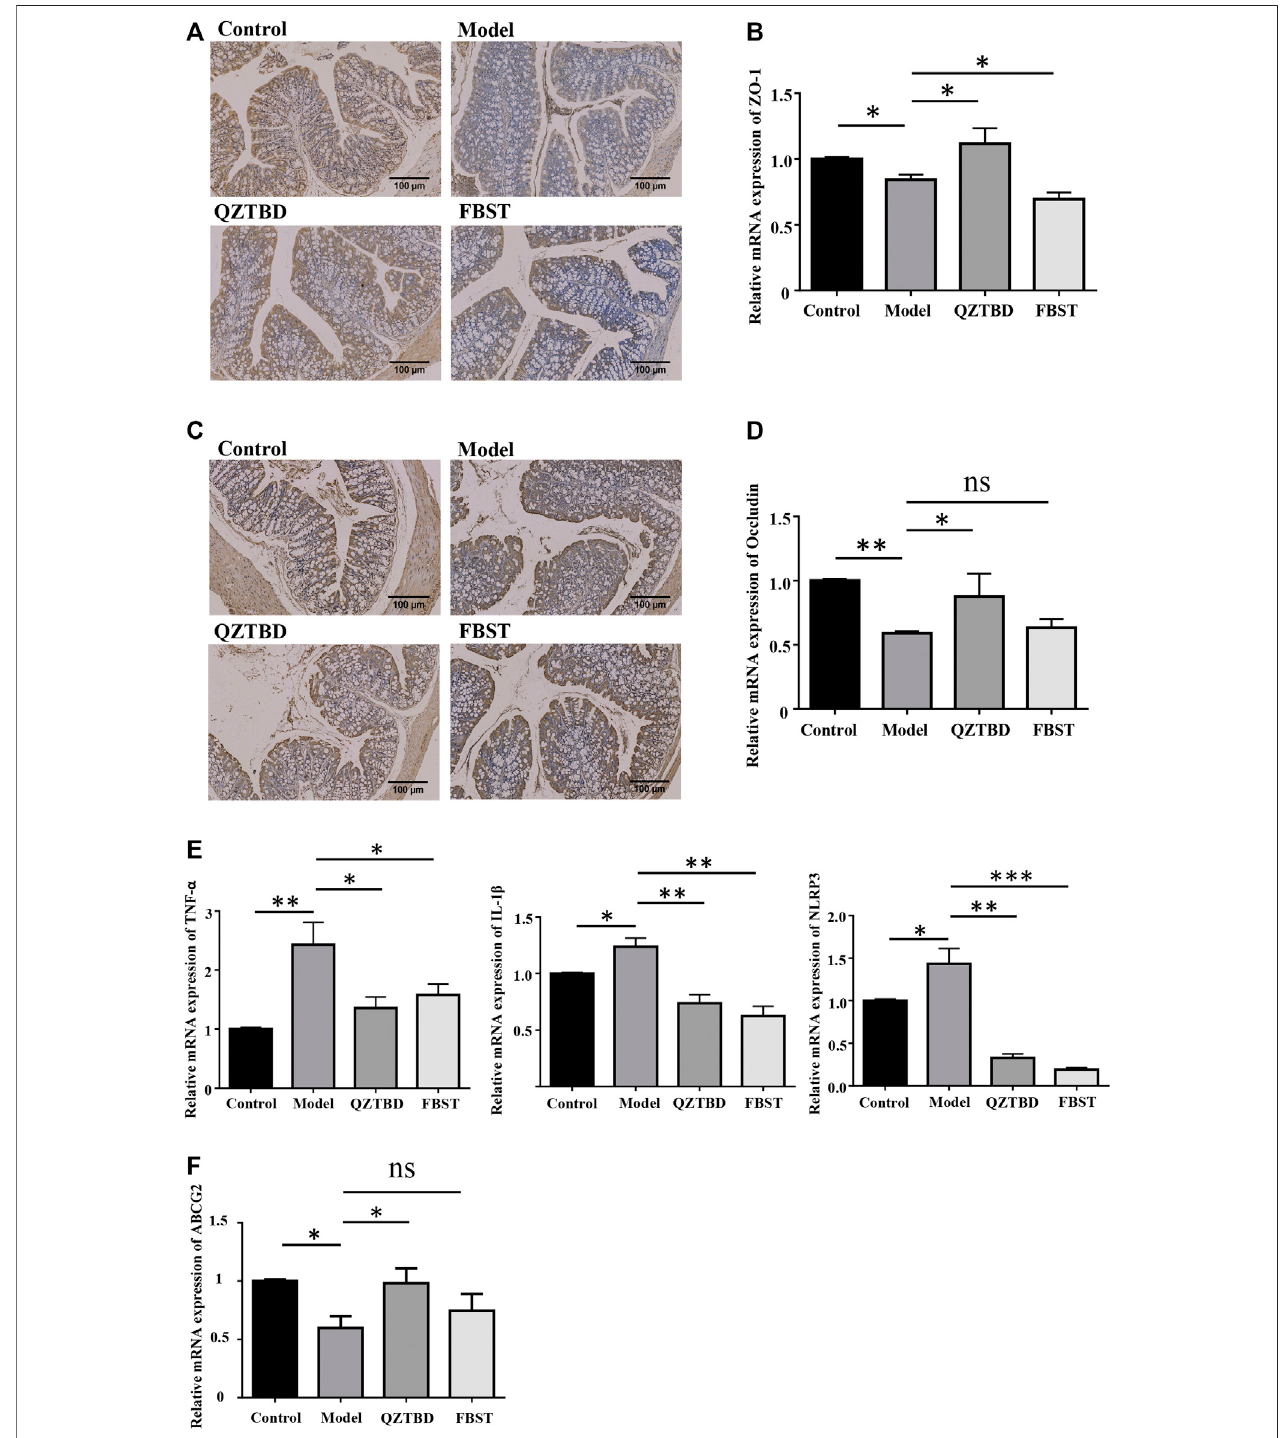
FIGURE 6 | QZTBD improved intestinal mucosal barrier. Expression of ZO-1 in the colon was measured by immunohistochemistry (A) and q RT-PCR (B) ; Expression of Occludin in the colon was measured by immunohistochemistry (C) and q RT-PCR (D) ; The mRNA expression of in fl ammatory factors in the intestinal tissues (E) ; The mRNA expression of ABCG2 in the intestine (F) . “ ns ” represents not signi fi cant; “ * ” represents p < 0.05, “ ** ” represents p < 0.01 and “ *** ” represents p < 0.001. N (cid:2) 7/group.